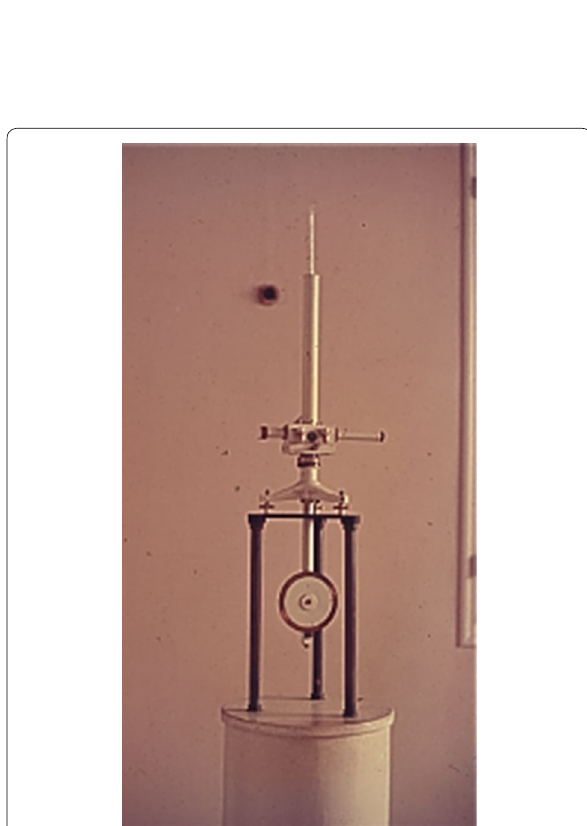
Fig. 8 BMZ at Ebro